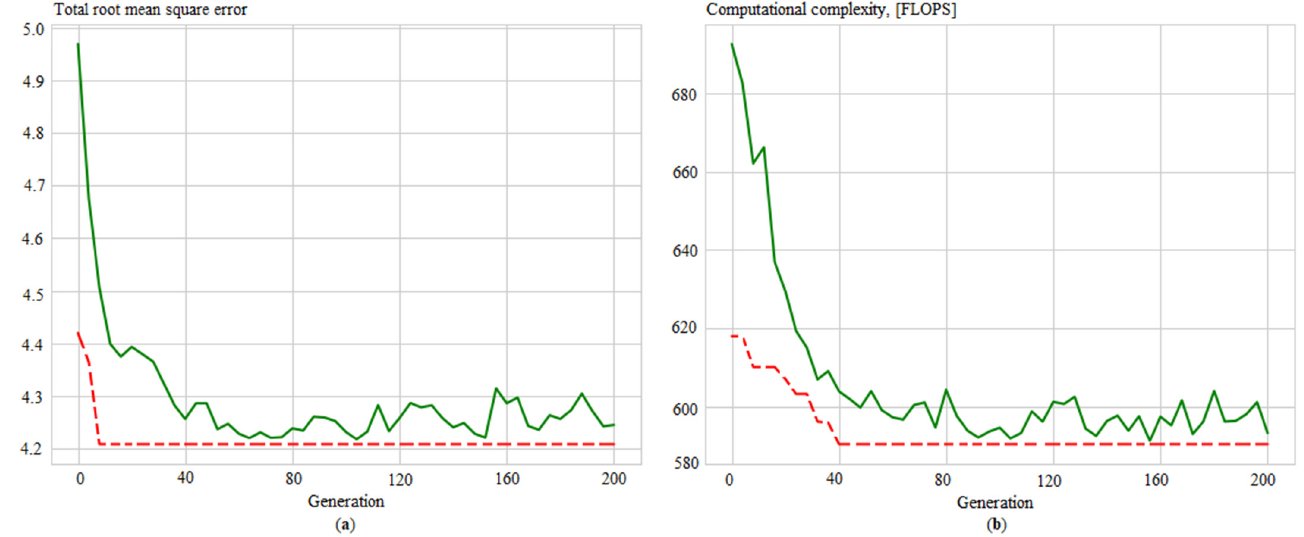
Figure 13. Evolution of the ANN corr in the process of determining its best structure by ( a ) total root mean square error; ( b ) computational complexity, where solid green lines are average values per generation, and dotted red lines are minimum values per generation.